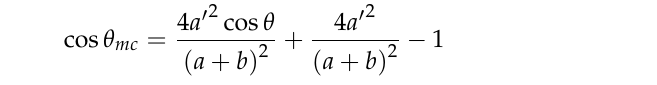
Table 3. Dimension parameters for the design of cruciform secondary microstructures.